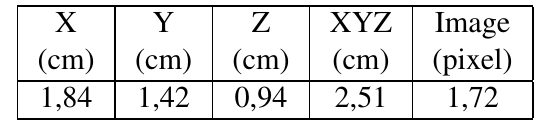
Table 2: Terrestrial and images residuals on GCPs after camera